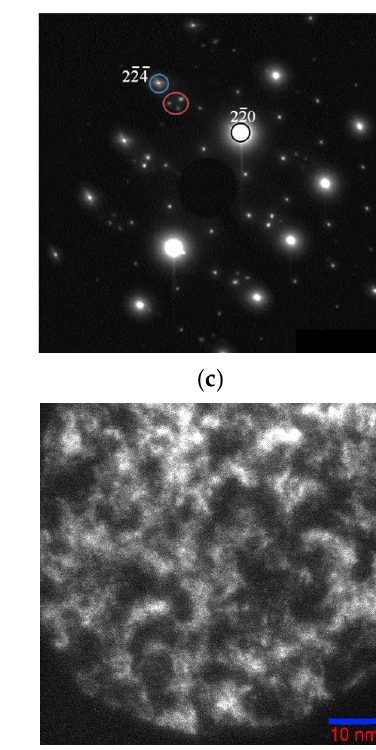
the boundaries between domains are coherent.